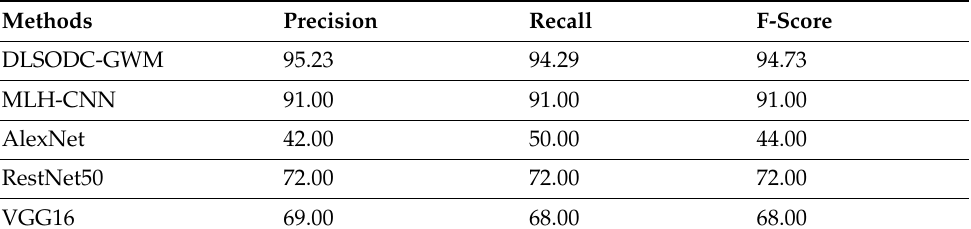
Table 4. Comparative analysis of DLSODC-GWM technique with recent approaches.